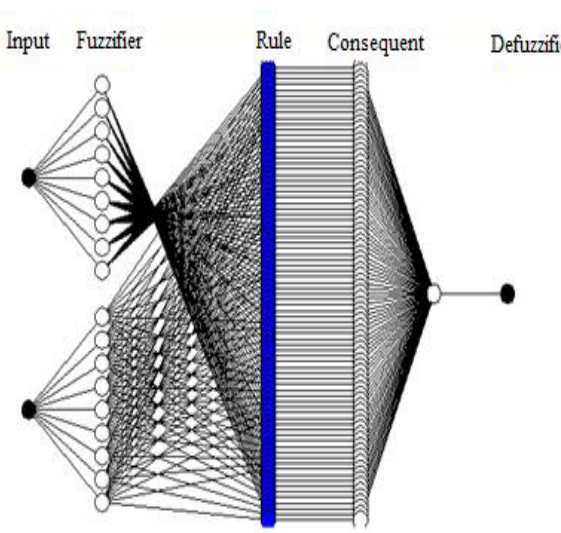
Figure 12. Training model for FNNREM